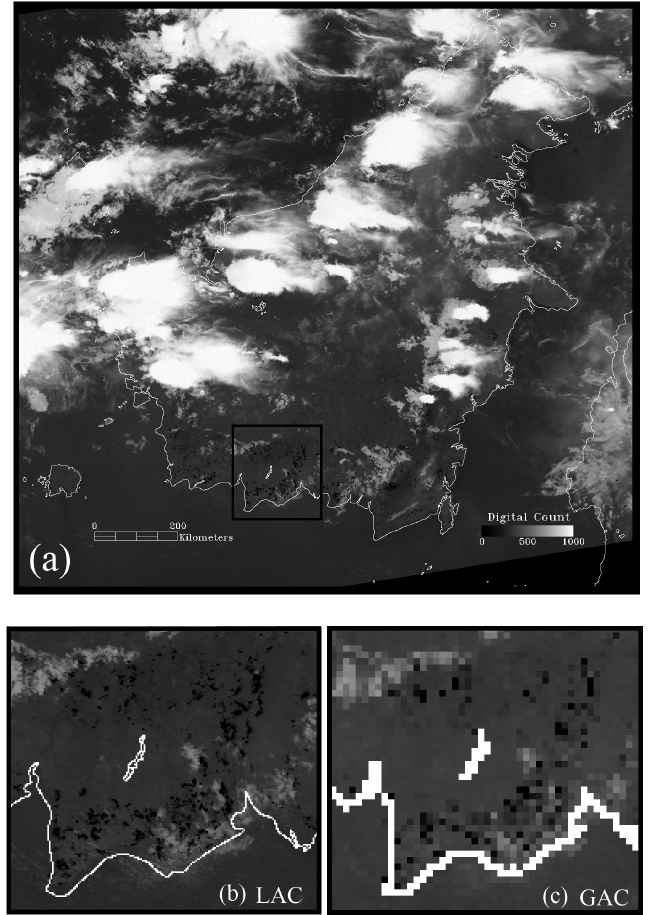
Fig. 3. Matching nighttime AVHRR 3.7µm channel LAC and GAC data of Borneo taken on 12 October 1997 during the height of the El Ni˜no episode when many fires were burning, particularly along the coast of Central Kalimantan (Wooster and Strub, 2002). Data are shown in an uncalibrated form to aid interpretation, resulting in high radiance (i.e. low AVHRR digital count) fire pixels appearing black in this rendition. A raster coastline is superimposed on the imagery to outline the island of Borneo. Plate (a) shows the full AVHRR LAC scene of Borneo, with the most heavily fire-affected area outlined in black. This area is shown magnified in the LAC and matching GAC data subsets shown as (b) and (c) respectively. Despite the GAC sampling and pixel averaging process, the low digital count fire pixels are seen in both LAC and GAC data formats. Data are shown geometrically corrected to aid the visual